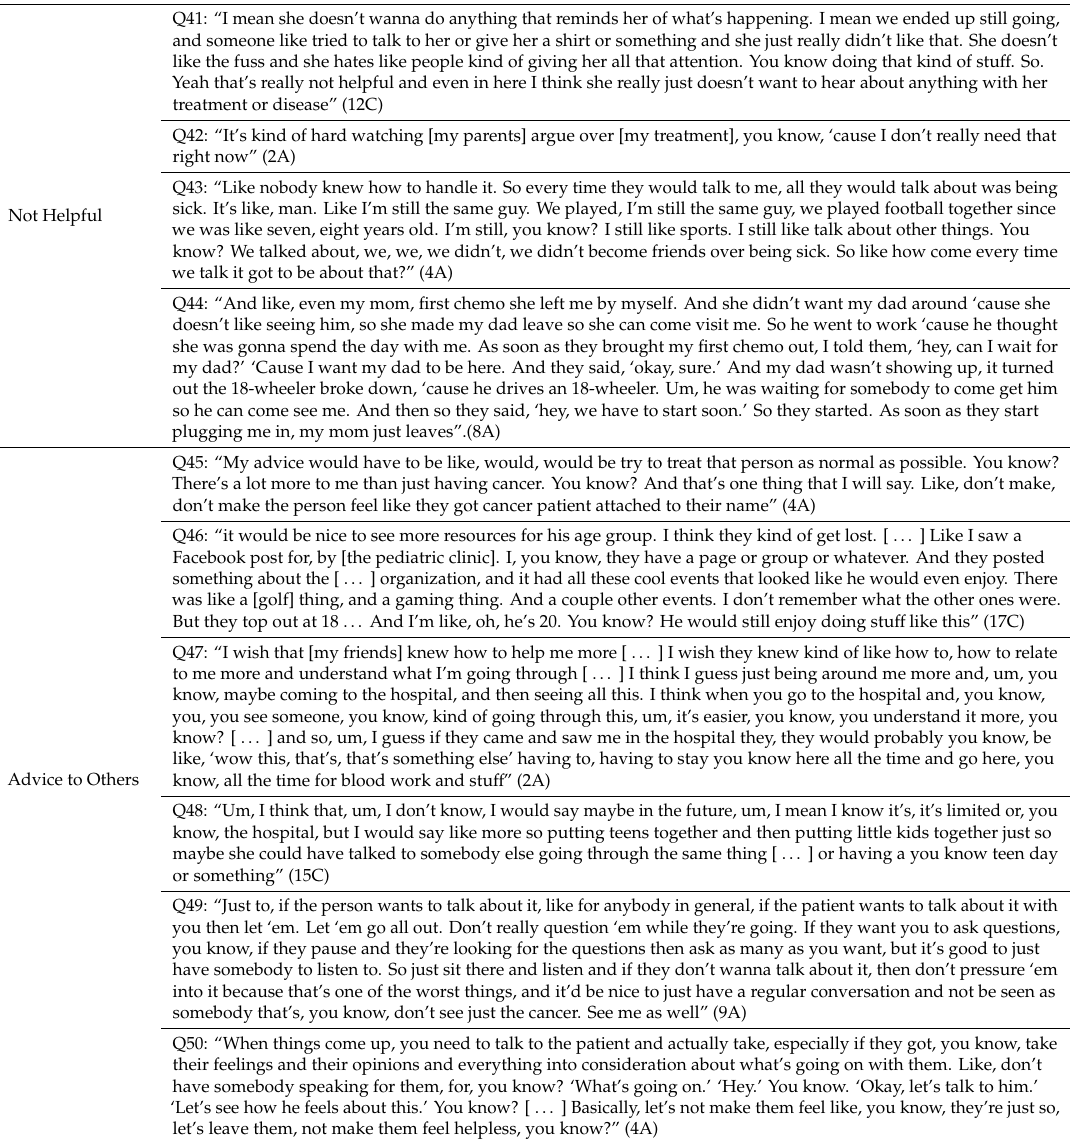
Table 6. Opinions /